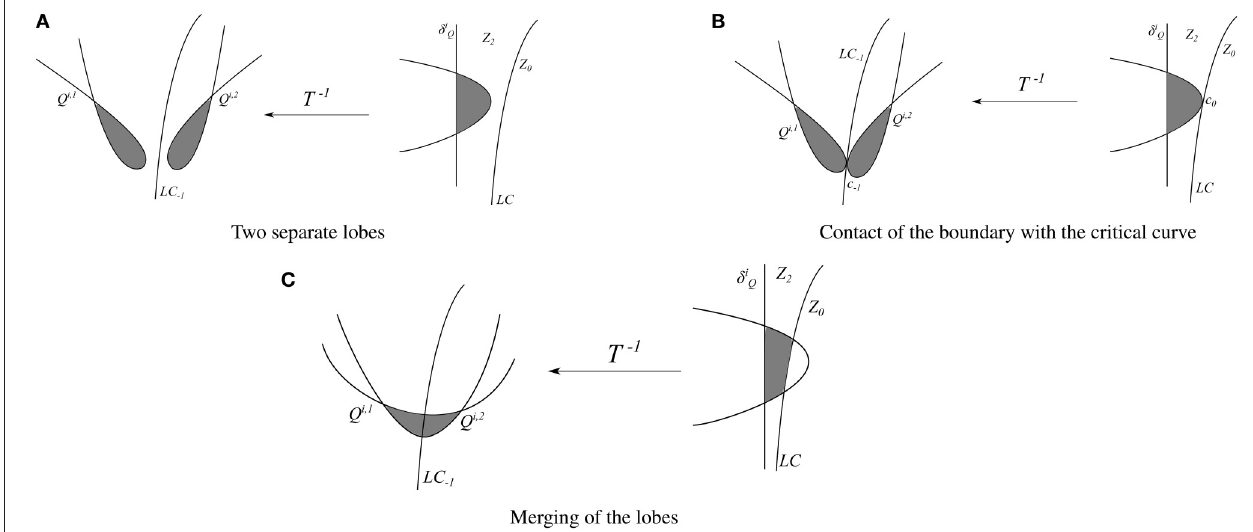
FIGURE 4 | The creation of crescents as the result of merging of lobes. (A) Two separate lobes. (B) Contact of the boundary with the critical curve. (C) Merging of the